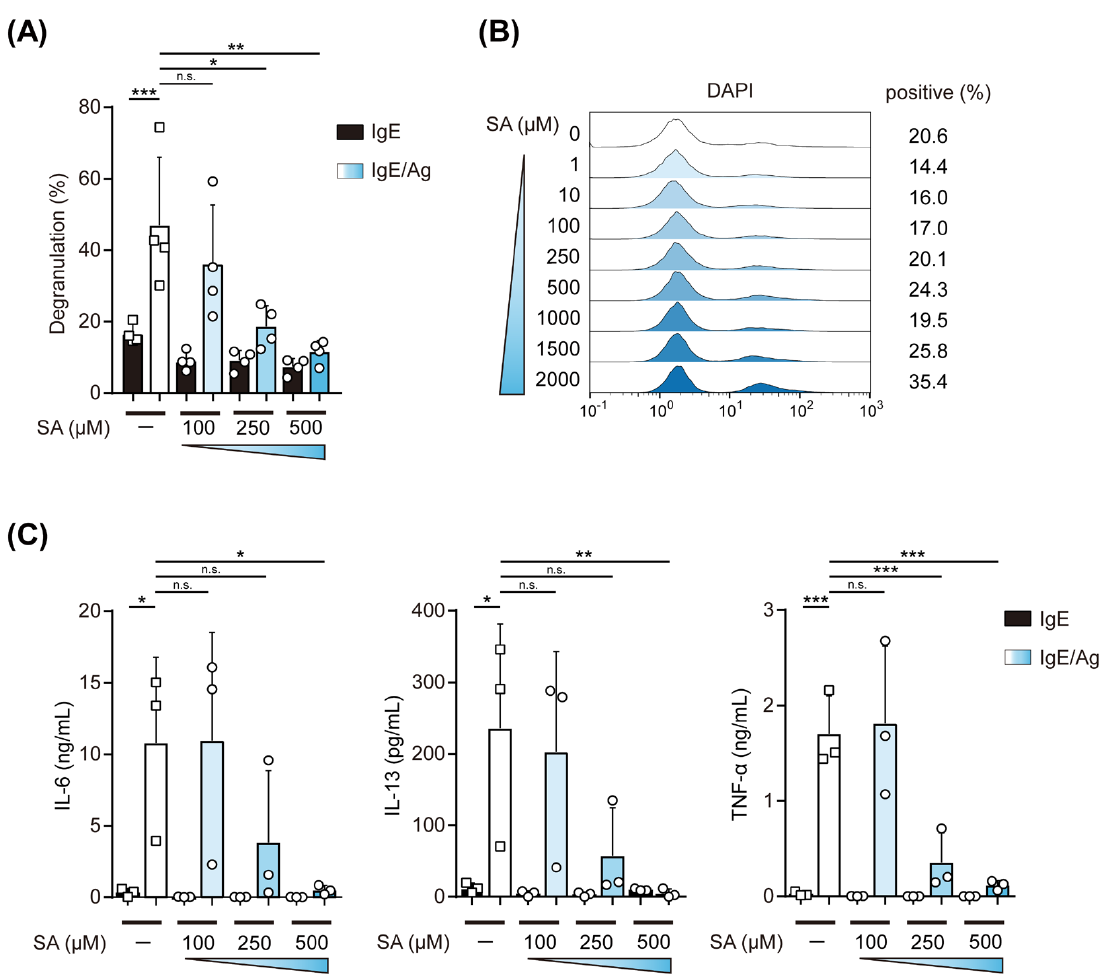
Figure 2. Salicylaldehyde inhibited the degranulation of and cytokine production by IgE-stimulated MCs. ( A ) Effects of salicylaldehyde on the IgE-mediated degranulation of BMMCs. BMMCs were incubated in the presence or absence of the indicated concentrations of salicylaldehyde (SA) for 48 h. After sensitization with IgE, BMMCs were incubated in Tyrode’s buffer containing TNP-BSA (IgE/Ag) or without Ag (IgE), and the supernatant was collected for β -hexosaminidase assay. ( B ) Effects of salicylaldehyde on the viability of BMMCs. BMMCs incubated with the indicated concentrations of salicylaldehyde (SA) for 48 h were treated with DAPI. DAPI-stained cells were judged to be dead cells. ( C ) Inhibition of cytokine release from BMMCs by salicylaldehyde. BMMCs incubated in the presence or absence of the indicated concentrations of salicylaldehyde (SA) for 48 h were stimulated with TNP-BSA (Ag) after sensitization with IgE. Data shown in ( A , C ) represent the mean ± SD of 4 and 3 independent experiments, respectively. Dunnett’s multiple comparison test ( A , C ) was used for statistical analyses. *, p < 0.05; **, p < 0.01; ***, p < 0.001; n.s., not significant.